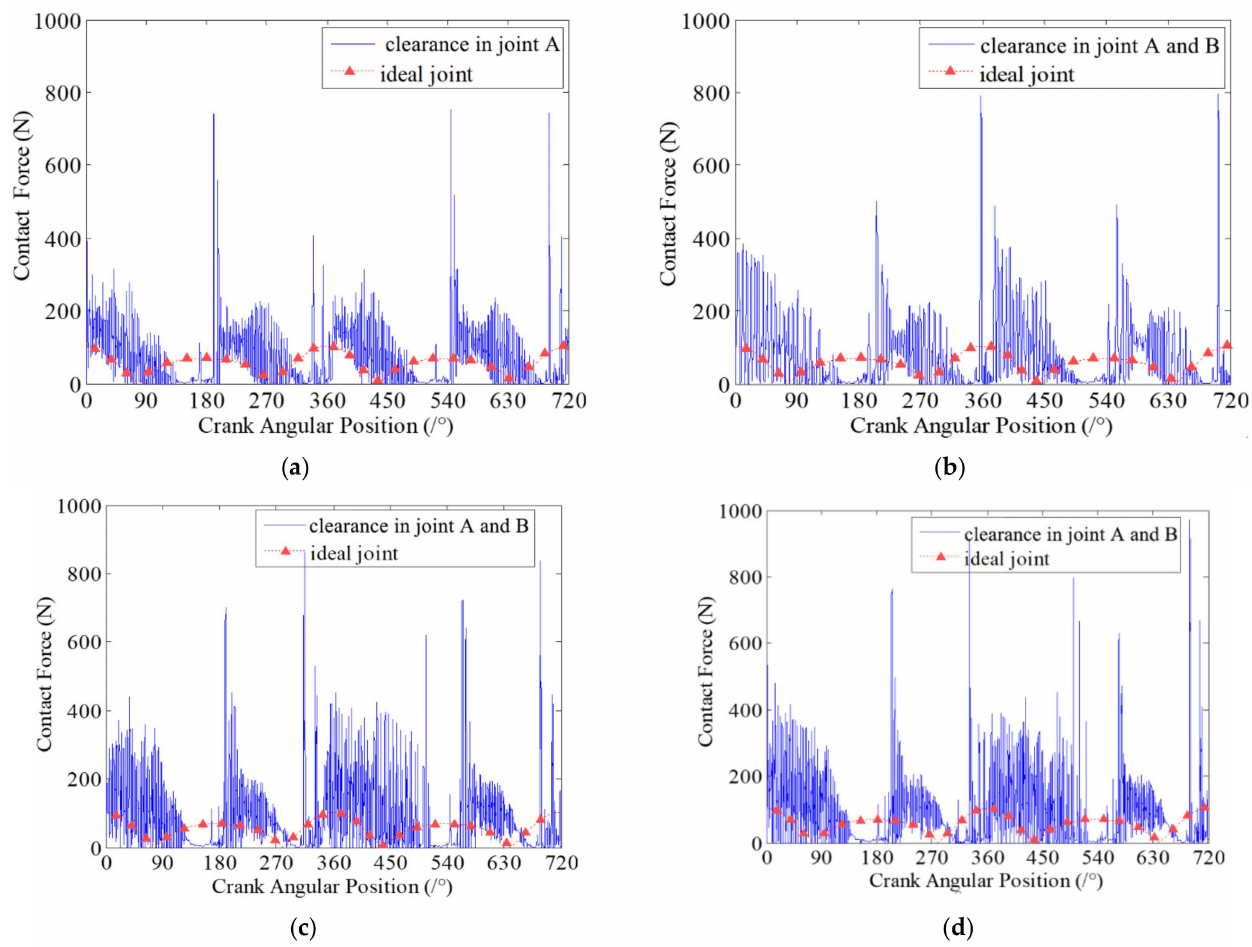
Figure 10. Contact forces in revolute clearance joint A for different cases. ( a ) 1 × 10 6 N/mm; ( b ) 5 × 10 6 N/mm; ( c ) 1 × 10 7 N/mm; ( d ) 5 × 10 7